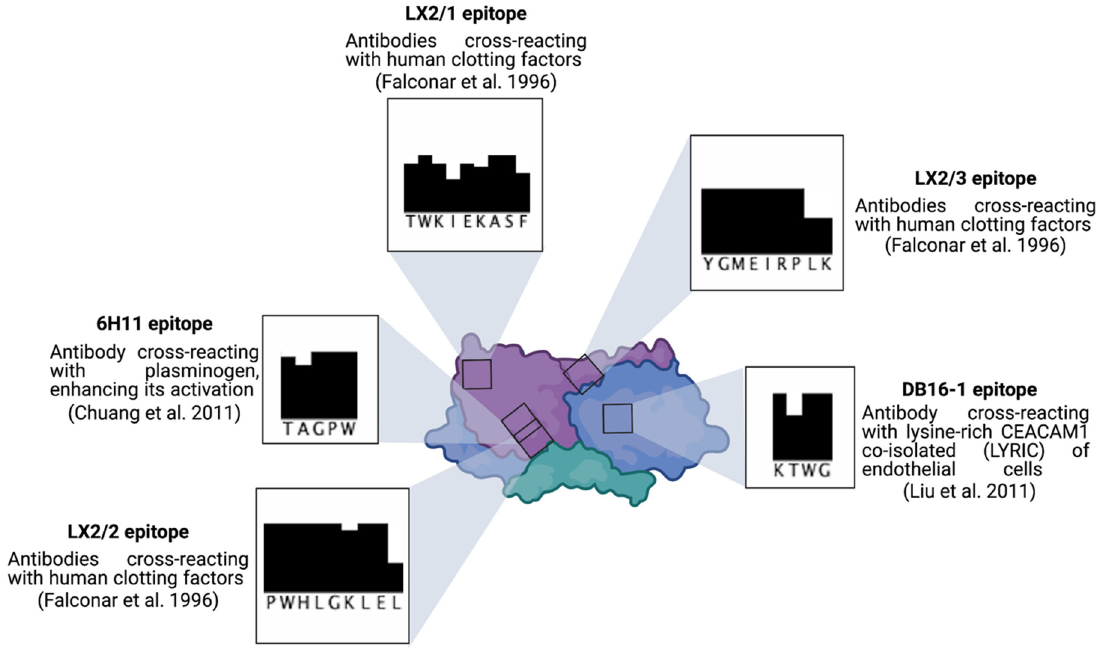
Figure 3. NS1 epitopes in relation to autoantibodies. The NS1 protein is found in circulation during the infection; thus, the existence of molecular mimicry between conserved NS1 epitopes and host proteins may lead to the production of autoantibodies. For instance, the recognition of NS1 epitopes LX2/1, LX2/2 and LX2/3 can engender antibodies cross-reacting with human clotting factors [28], whereas, NS1 epitope KXWG leads to the production of the DB16-1 antibody cross-reacting with lysine-rich CEACAM1 co-isolated (LYRIC) of endothelial cells, promoting cell death by apoptosis [26]. Finally, the 6H11 antibody, which recognizes the NS1 TAGPW epitope, also interacts with plasminogen and enhances its activation [29]. Wing domain (blue), β -roll domain (green), β -ladder domain (purple). Black bars illustrate the conservation degree of the epitope sequence across dengue virus serotypes and genotypes.